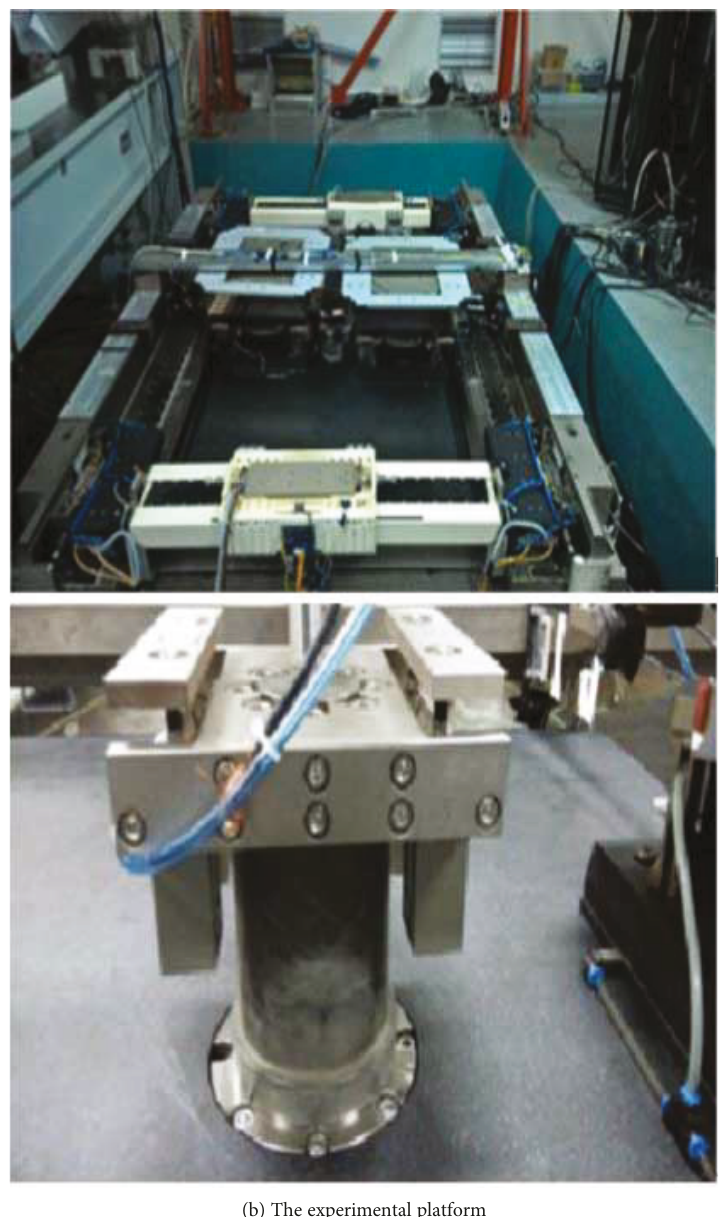
Figure 5: Flow chart of the optimization process and the experimental